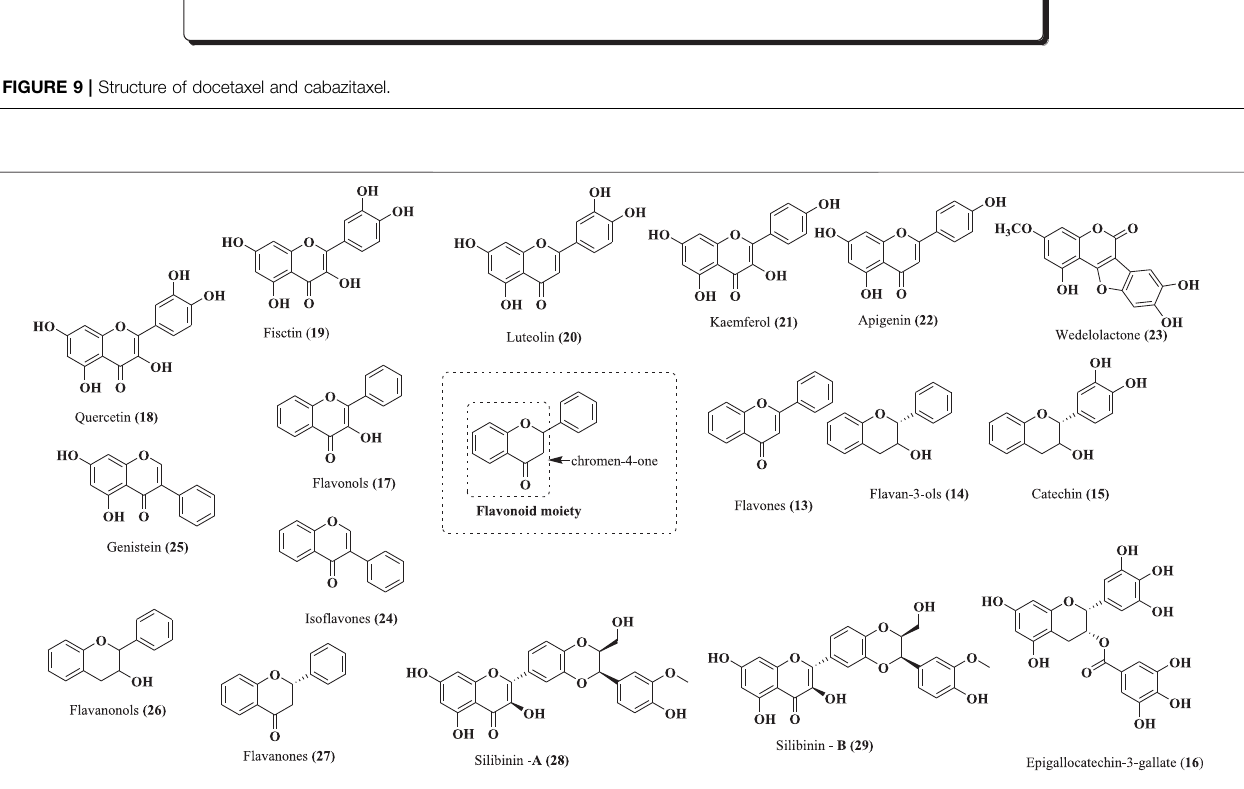
Frontiers in Pharmacology |